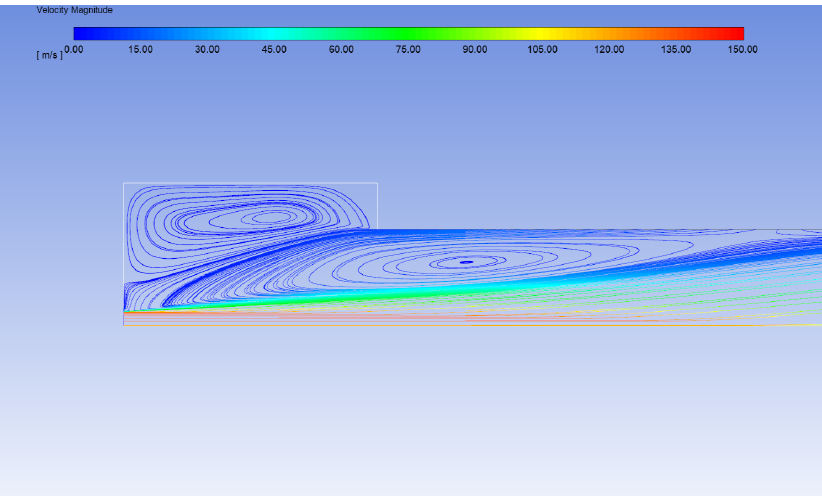
Figure 9. Pathlines showing large vortices in prechamber caused by the conical injection—test 7, HDPE.